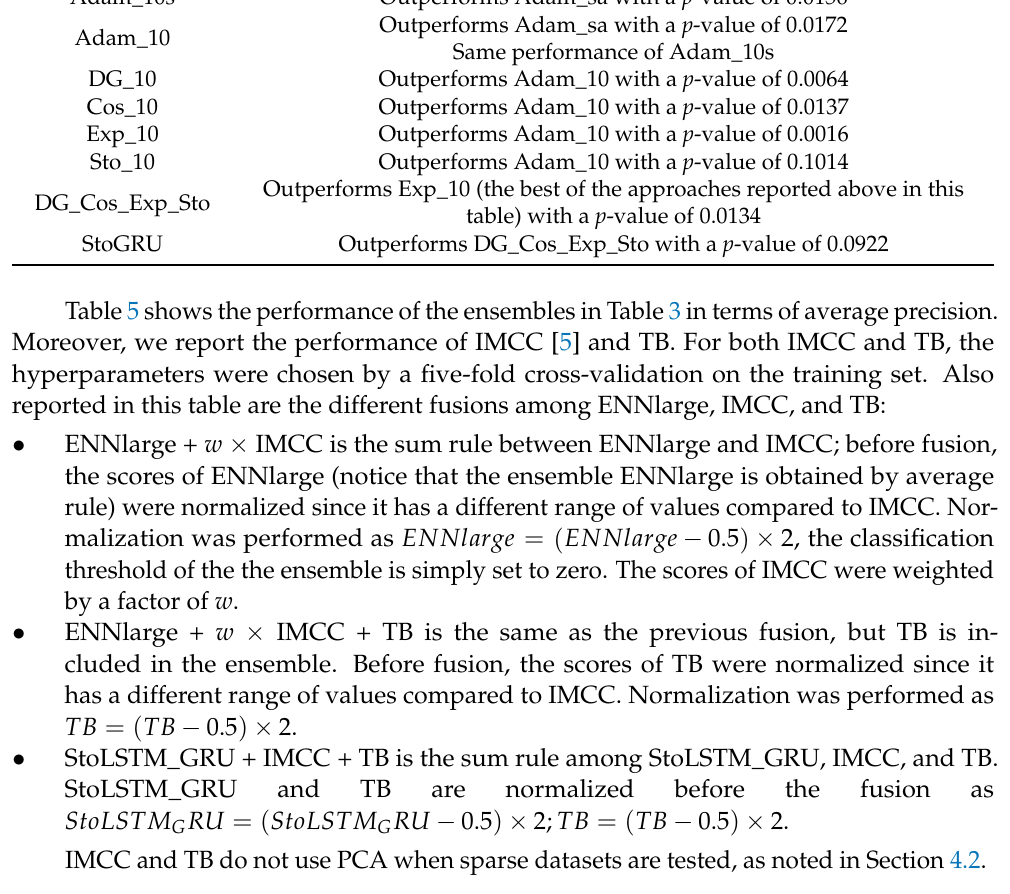
Table 4. Ablation study showing that StoGRU is the best method among the approaches based on GRU_A (other approaches produced similar results).